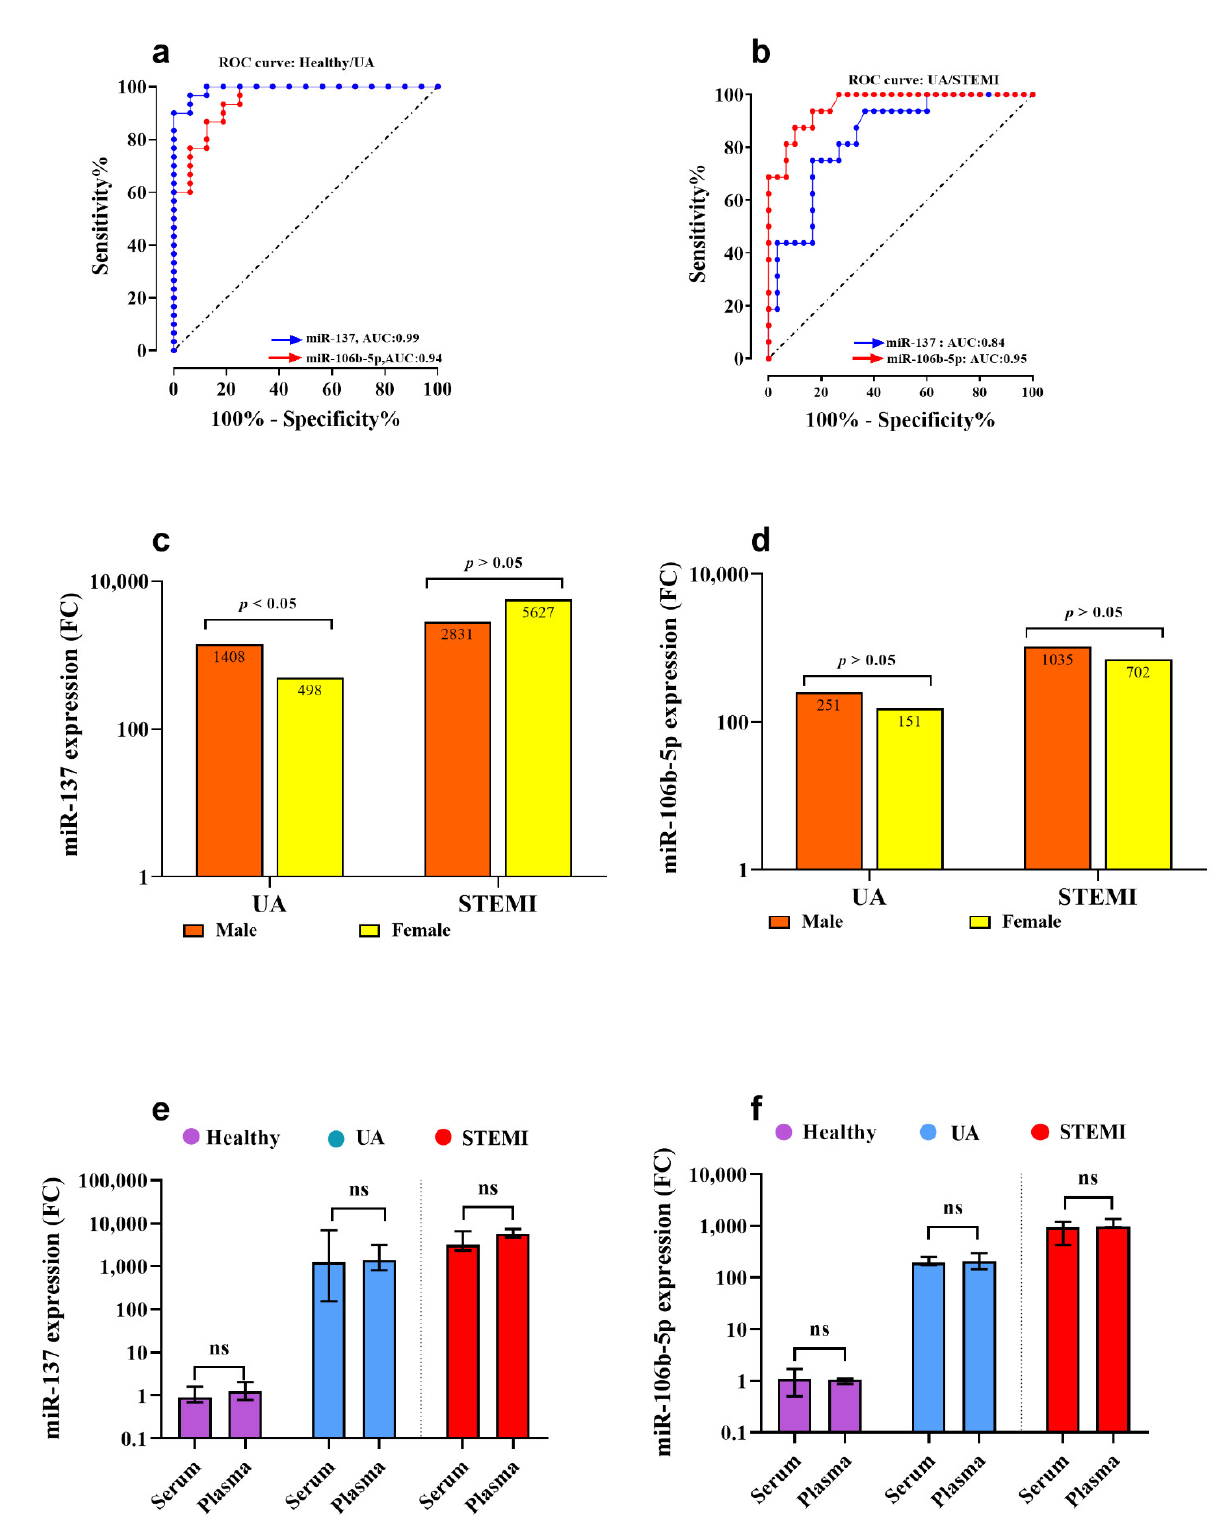
Figure 4. Receiver operator characteristics (ROC) curve illustrating the diagnostic value of the two miRNAs ( miR-137 and miR-106b-5p ) in discriminating UA from Healthy ( a ) and UA from STEMI ( b ). ( c , d ) show the nonsignificant association of miR-106b-5p expression level between genders in UA and AMI patients, respectively. Finally, the serum and plasma expression levels for miR-137 ( e ) and miR-106b-5p ( f ) were compared, and results indicate no significant difference was reached. Abbreviations: UA: unstable angina, STEMI: ST-elevation myocardial infarction, AUC: area under the curve, p -value > 0.05 considered statistically insignificant, and p -value < 0.05 considered statistically